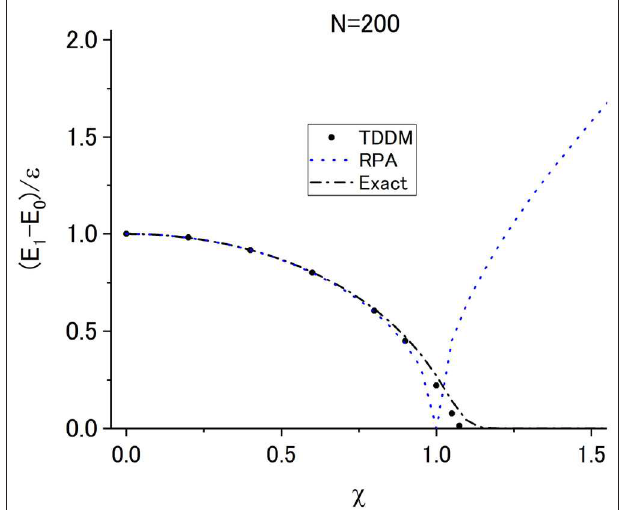
FIGURE 3 | Excitation energy of the first excited state calculated in TDDM (dots) as a function of χ for N 200. The exact values are shown with the = dot-dashed line. The dotted line depicts the results in RPA. Adapted from a Italiana di Tohyama and Schuck [45] with permission from Societ ` Fisica/Springer-Verlag GmbH Germany.